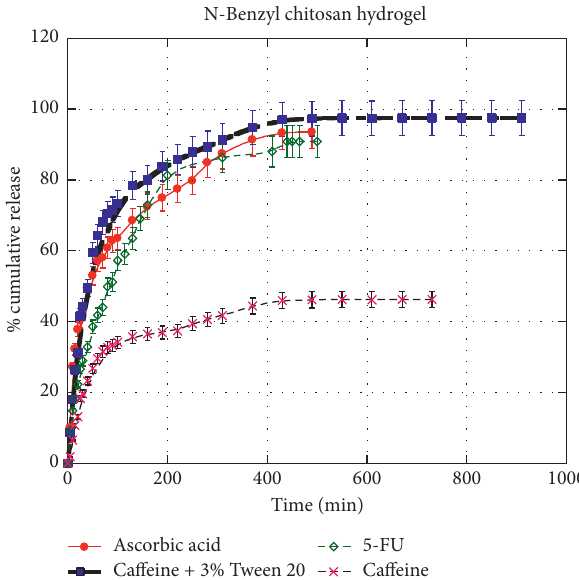
Figure 14: In vitro drug release from hydrogels at 37 ° C in PBS at pH